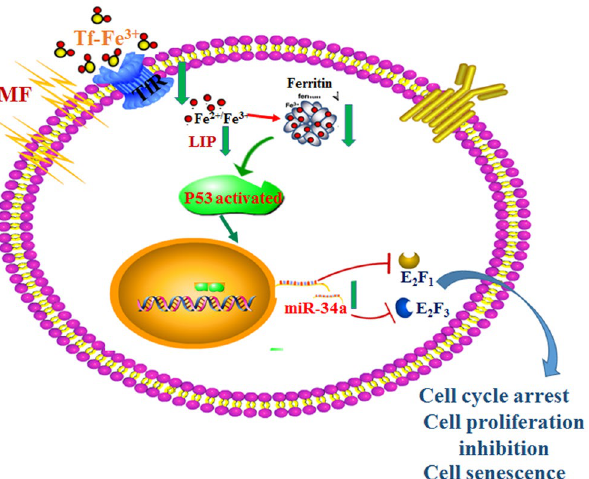
Figure 8. Working model of LF-MF induced cell proliferation inhibition, cell cycle arrest and cell